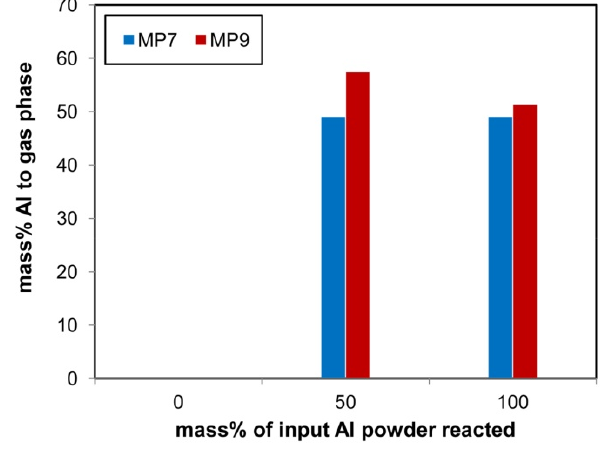
Figure 8. Expected aluminium loss to gas according to gas ‐ slag ‐ metal powder equilibrium at 2500 °C: MP7 to MP9 comparison.